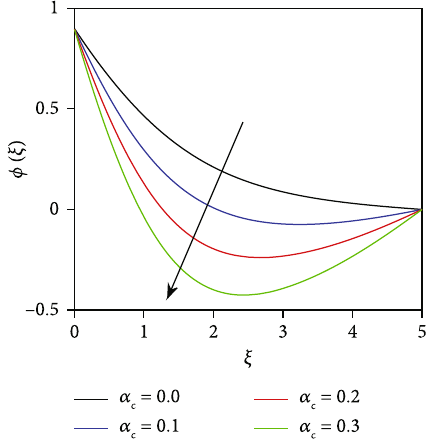
Figure 15: Concentration pro fi les for concentration relaxation . parameter α c